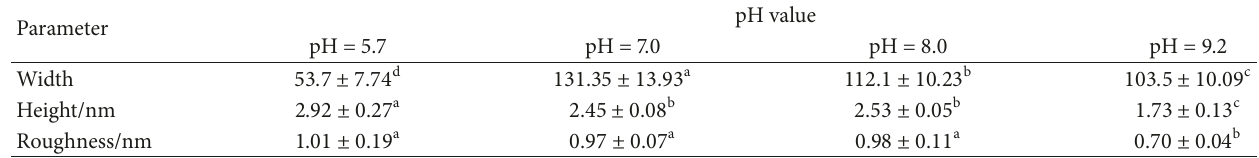
Figure 2: Typical AFM height images of collagen self-assembly at different pH values in 512 × 512 pixels: (a) pH 5.7; (b) pH 7.0; (c) pH 8.0; (d) pH 9.2. Table 2: Width, height, and roughness of the collagen self-assembly at different pH